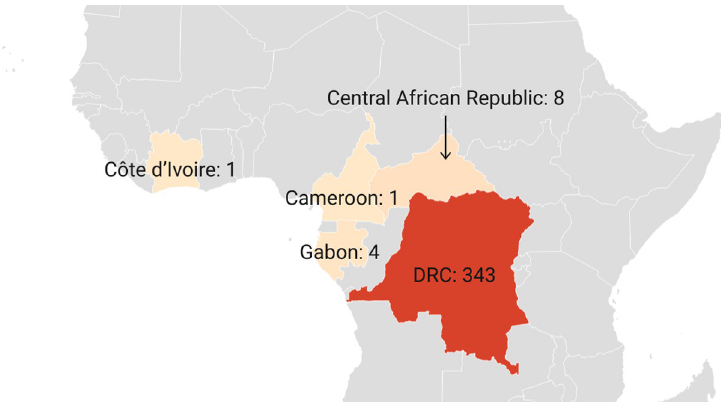
Fig 3. Number of confirmed, probable, and/or possible monkeypox cases between 1980–1989. [20,21,31,34,50,52,54] (base layer of the map: https://datawrapper.dwcdn.net/lGHEu/1/).